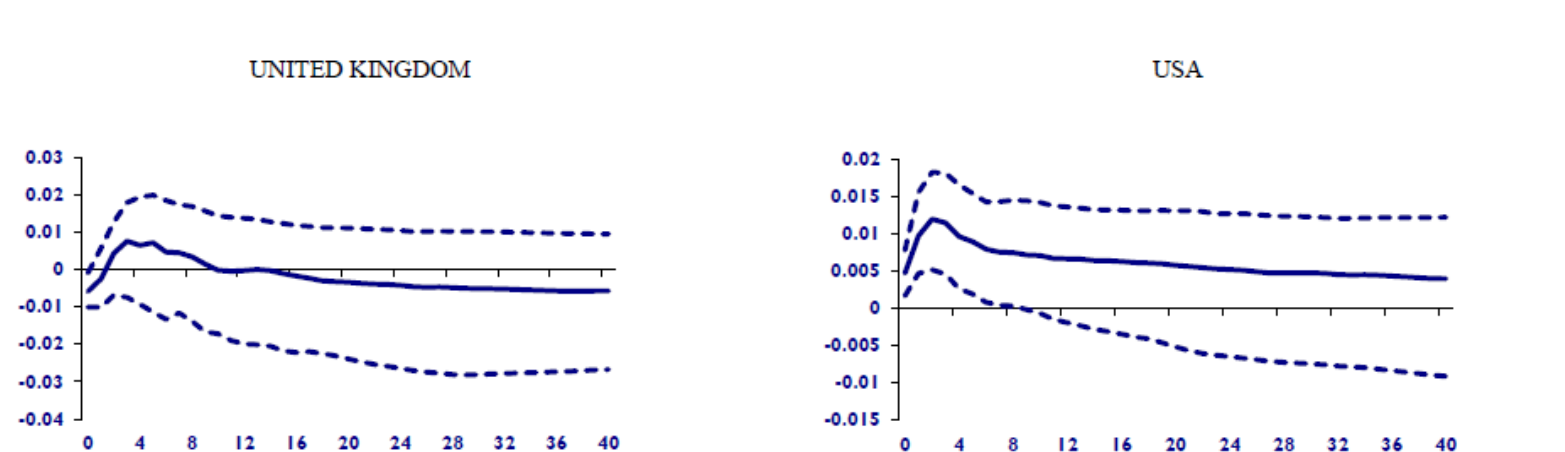
Figure 3. Country-specific oil price uncertainty shocks and real stock prices ( pre-gfc ). Note: The figure depicts the country-specific impulse response functions of real stock prices to a one standard deviation increase in oil price uncertainty. The median impulse response is presented in solid lines, while the 16–84% lower and upper bootstrapped error bands are shown in dotted lines. The impact is measured in percentage points (by multiplying the estimates in the figure with 100) over the quarterly horizon.